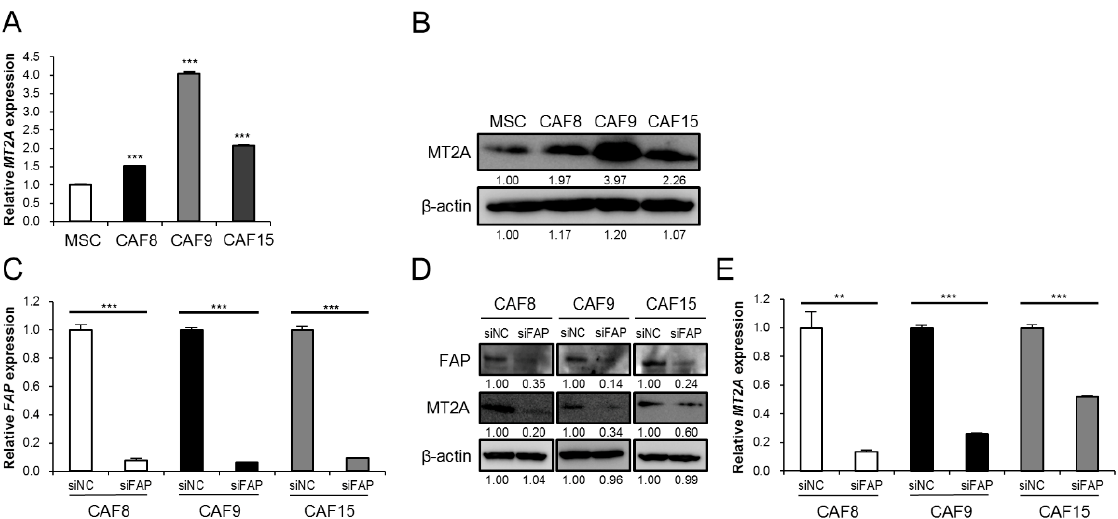
Figure 1. FAP regulates MT2A expression upstream in CAF-like cells. ( A , B ). The expression of MT2A mRNA and MT2A protein in mesenchymal stem cells (MSCs), CAF8, CAF9, and CAF15 cells was detected by quantitative real-time-PCR (qRT-PCR) ( A ) and Western blotting ( B ). After Western blotting, the normalized relative expression fold-change were calculated using the ImageJ software, and the values were arbitrarily set as 1.00 for control MSCs. ( C – E ). qRT-PCR ( C,E ) and Western blotting ( D ) to confirm FAP knockdown and change in the expression of MT2A. The three types of CAF-like cells were transfected with siRNA targeting FAP (siFAP) and the negative control siRNA (siNC). After Western blotting, the normalized relative expression fold-change were calculated using the ImageJ software, and the values were arbitrarily set as 1.00 for cells transfected with control siNC. Data are presented as mean ± SEM (** p < 0.01, *** p < 0.001).